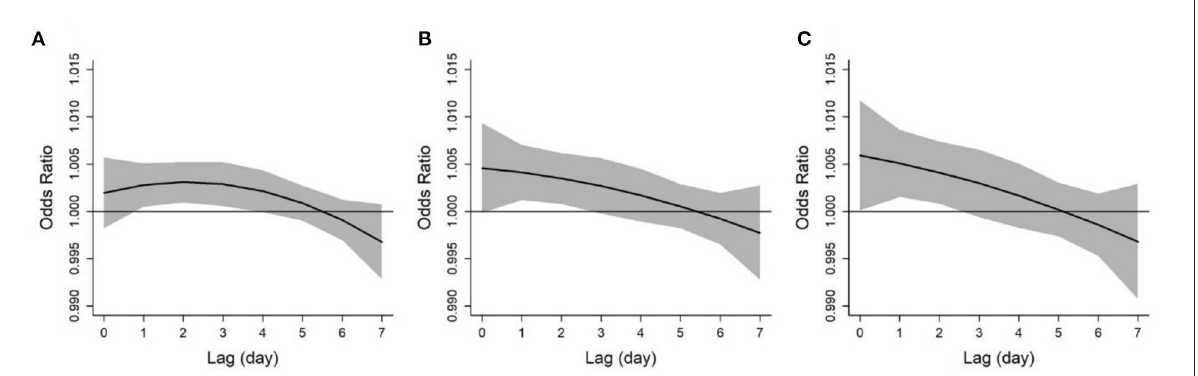
FIGURE2 Lag patterns for the associations between ozone and asthma exacerbations defined by diurnal peak expiratory flow variation over 10% (A) , 15% (B) , and 20% (C) . The solid lines and shaded areas represent odds ratios and the 95% confidence intervals, respectively.